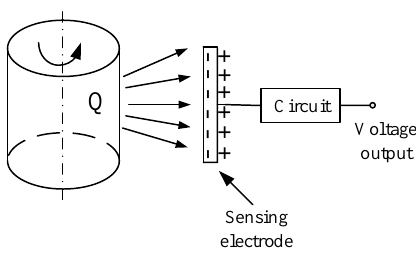
Figure 1. Measurement principle using the electrostatic method.